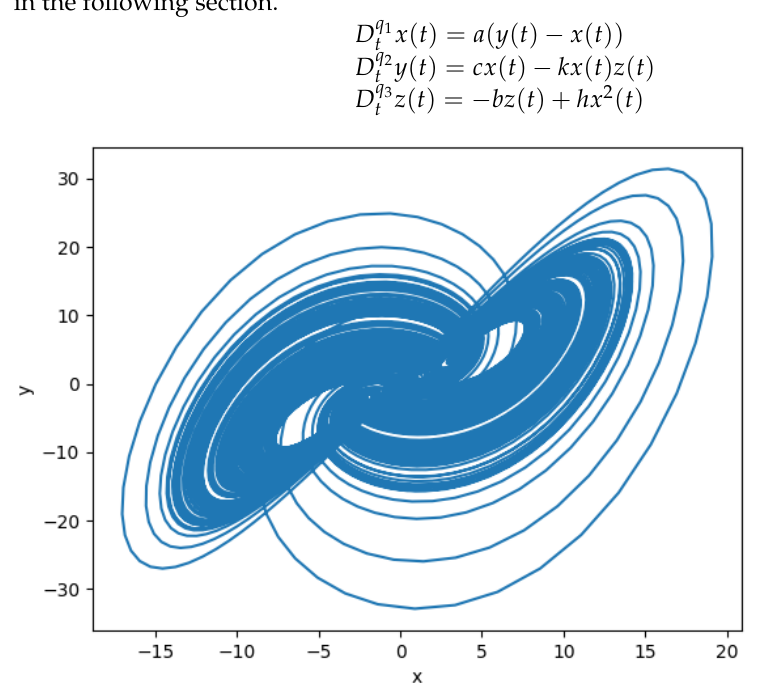
Figure 2. Liu attractor generated from (4) by setting a = 10, b = 2.5, c = 40, k = 1, h = 4, and